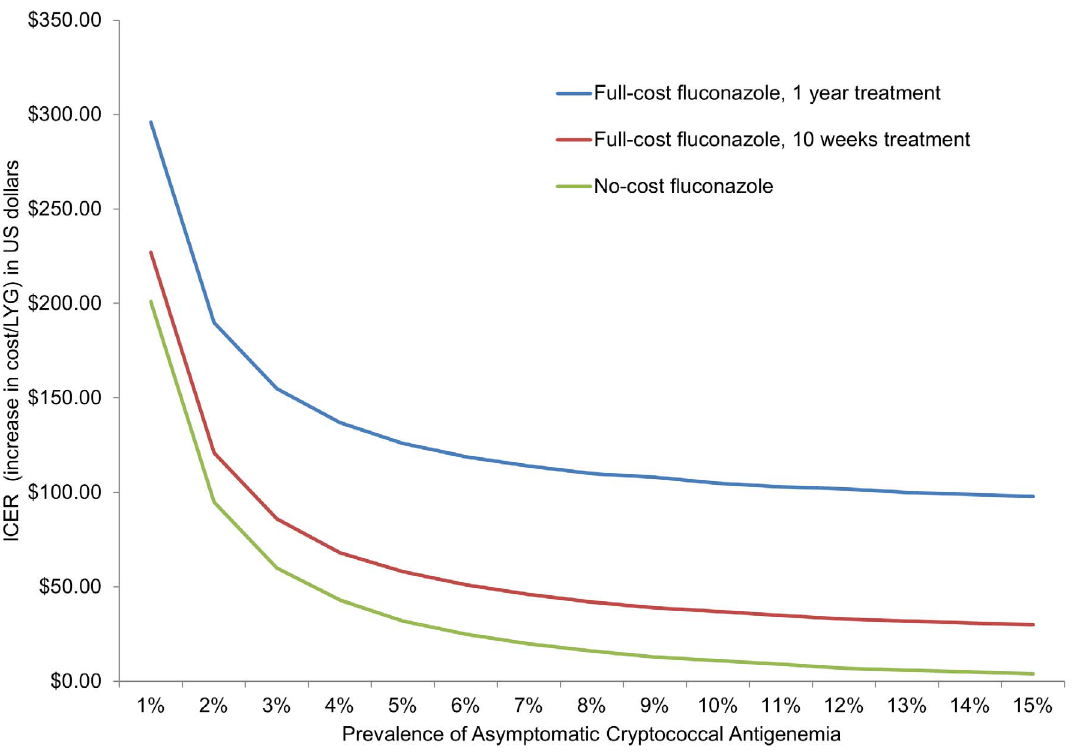
Figure 2. Cost-effectiveness of cryptococcal screening at a range of prevalences and cost scenarios. This graph has prevalence of asymptomatic cryptococcal antigenemia on the x-axis and incremental cost-effectiveness ratio (ICER) (increased cost per life-year gained [LYG] in US dollars) on the y-axis. The blue line represents the cost curve of full-cost fluconazole for one year of treatment. The red line represents the cost curve of full-cost fluconazole for ten weeks of treatment; the green line represents the cost curve of if fluconazole is obtained at no-cost. For Vietnam, the World Health Organization considers any intervention with an ICER under $ 6,948 to be ‘highly cost-effective’. This graph shows that cryptococcal screening, at any prevalence and under each of the three cost scenarios, should be considered a highly cost-effective intervention in Vietnam.